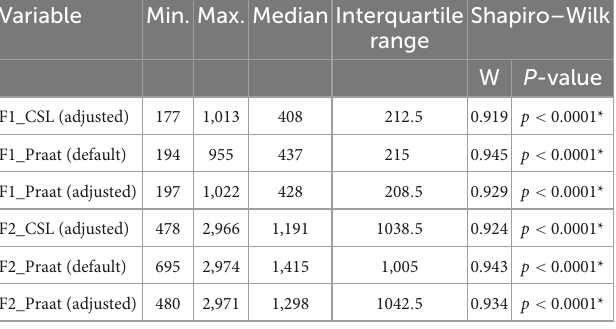
TABLE 2 Summary statistics and normality test results for F1 and F2 data obtained using Computerized Speech Lab (CSL) and Praat for all settings. Variable